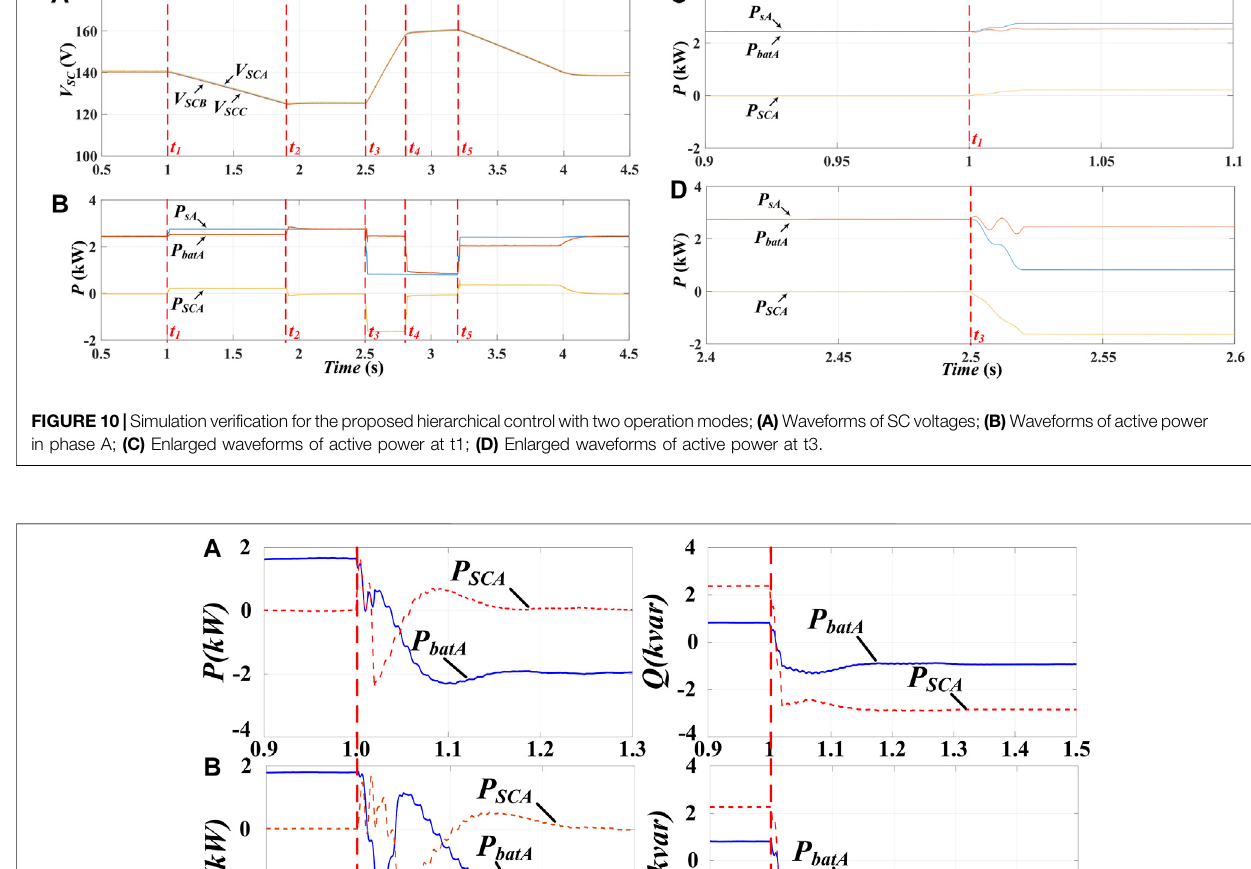
Frontiers in Energy Research |